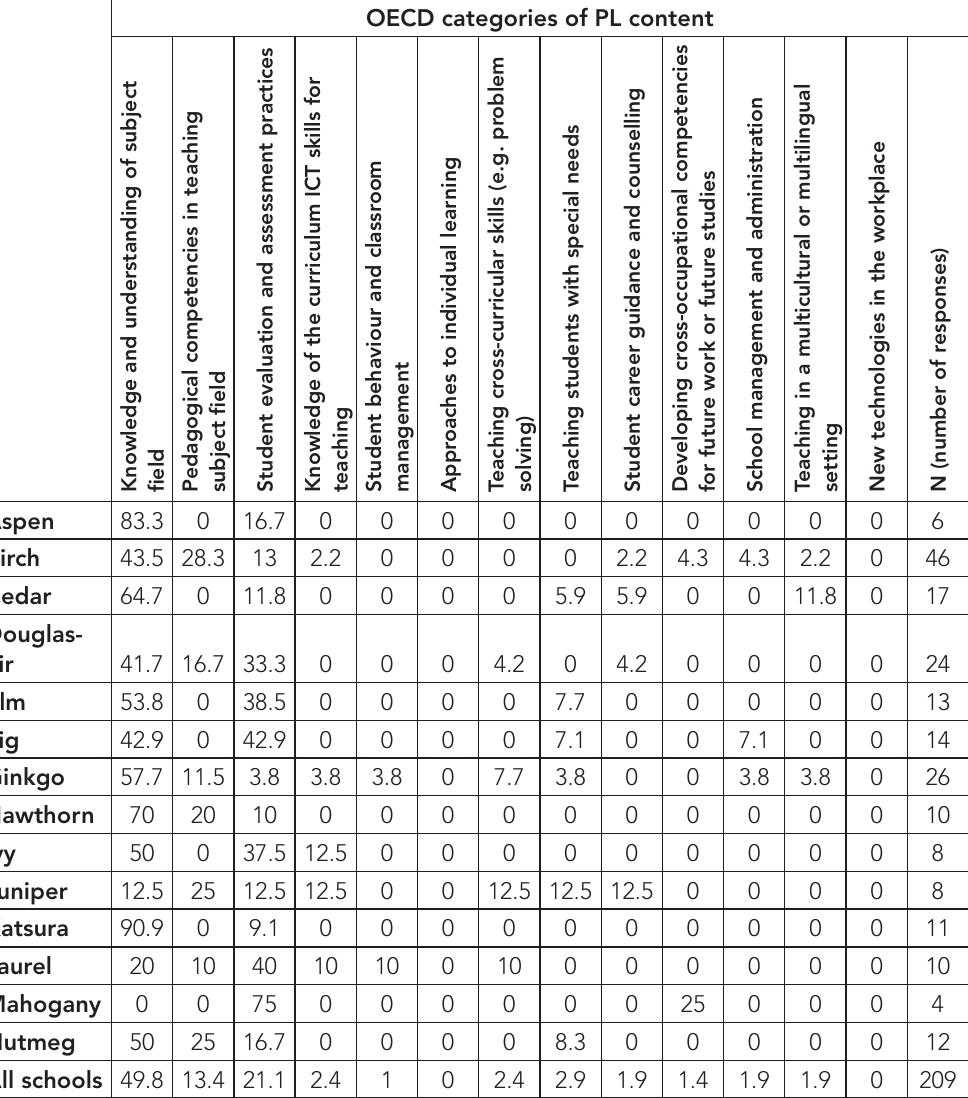
Table 3: Frequency (%) of teacher descriptions of their most valuable PL experiences between July 2016 and June 2017 by school* (teacher responses are categorized using the OECD PL content categories (Schleicher,